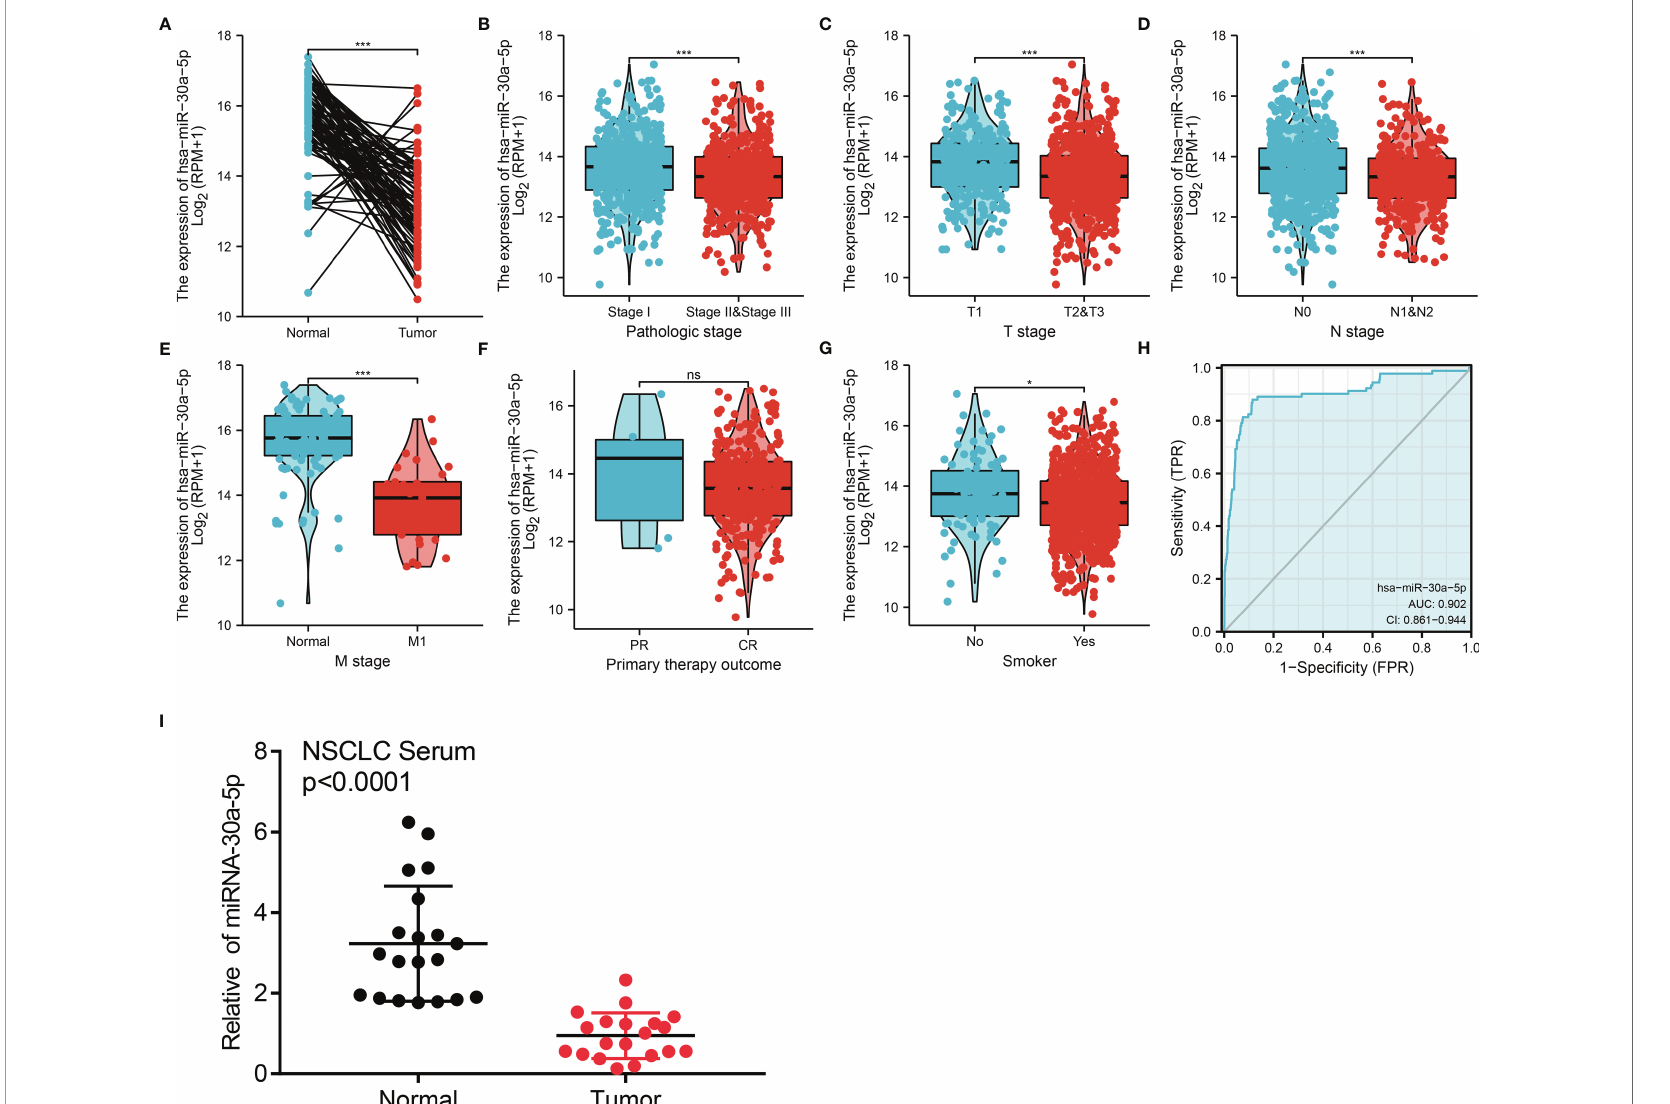
FIGURE 5 | miRNA-30a-5p was down-regulated in LUAD. (A) MiRNA-30a-5p was down-regulated in lung cancer based on TCGA-LAUD dataset. (B – G) Correlation between miRNA-30a-5p and clinicpathologic features, including the pathology stage, TNM stage, smoker, and therapy outcome in LUAD. (H) ROC curve analysis of miRNA-30a-5p showed an AUC value of 0.902 in LUAD. (I) miRNA-30a-5p was down-regulated in peripheral blood serum of LUAD analysed using qRT-PCR assay. *P < 0.05, ***P < 0.001. CR, complete response; PR, partial response; SD, stable disease; PD, progressive disease. NS: p